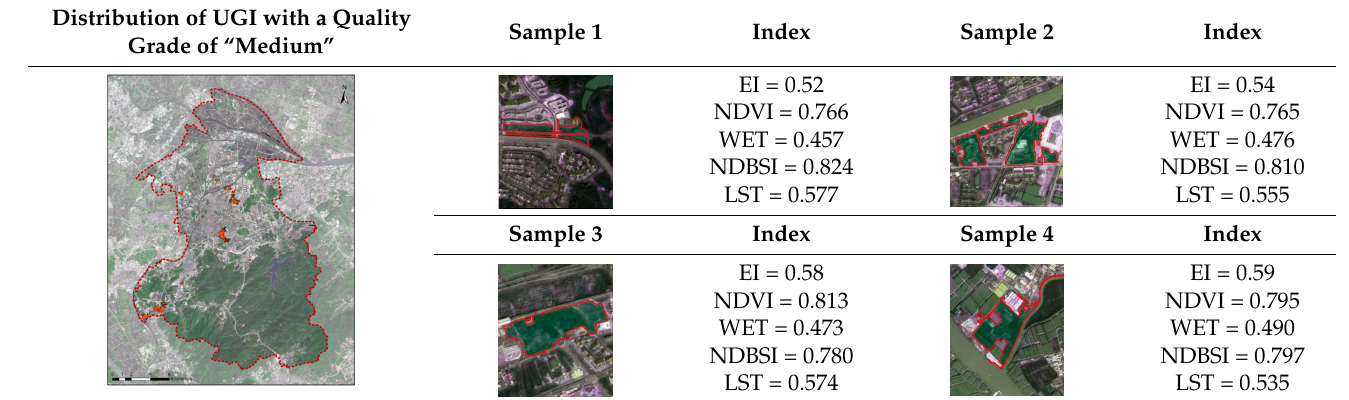
Table 9. Distribution and typical samples of UGI with a quality grade of “excellent”.